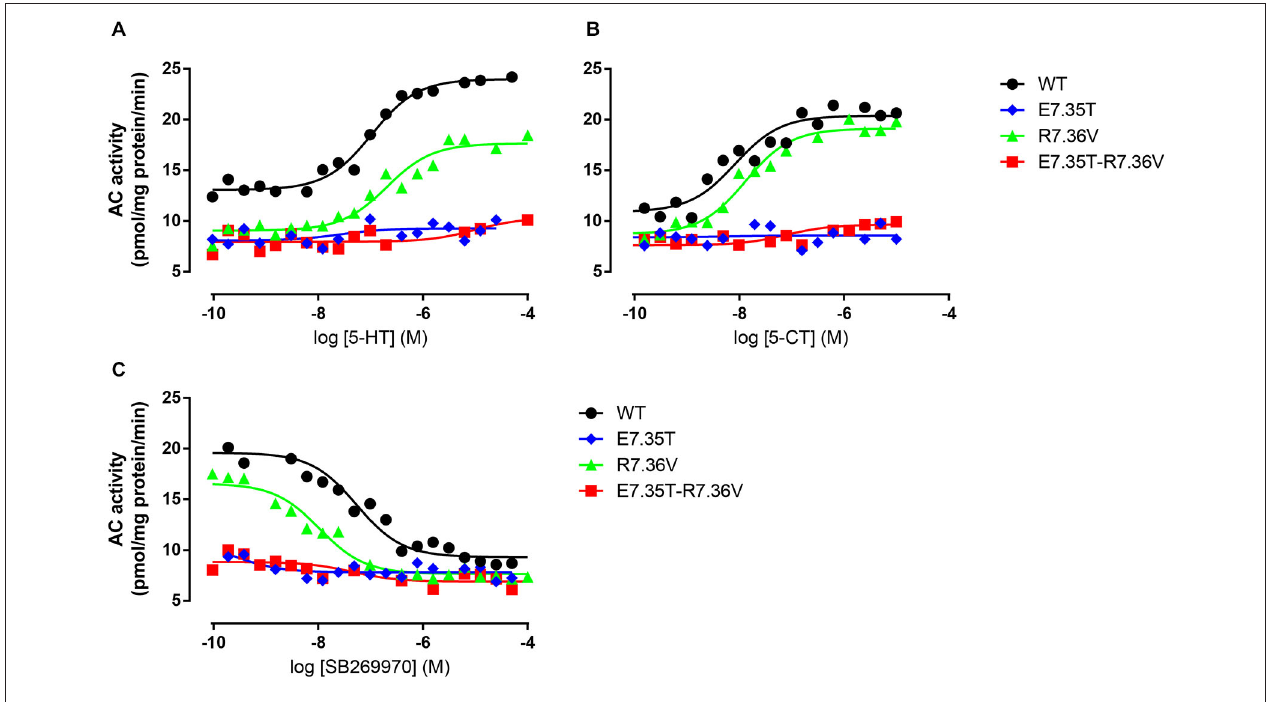
of increasing concentrations of SB269970 to antagonize 10 µ M 5-HT was determined. AC activity was measured as described under Materials and Methods , and the data shown are representative of those obtained from 1–3 independent